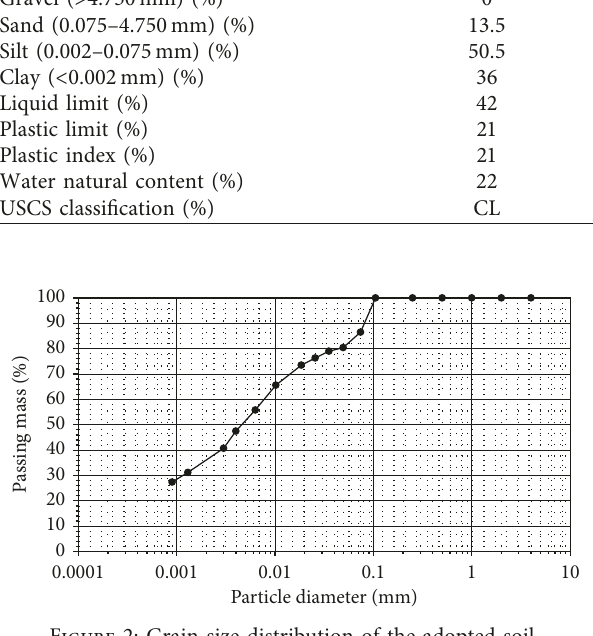
Figure 1: (a) Typical raw earth cob architecture at the “Villa Ficana” district of Macerata, Italy; (b) cob elements constituting an existing wall. Table 1: Geotechnical characterization of the soil used in this study. Soil used in this study